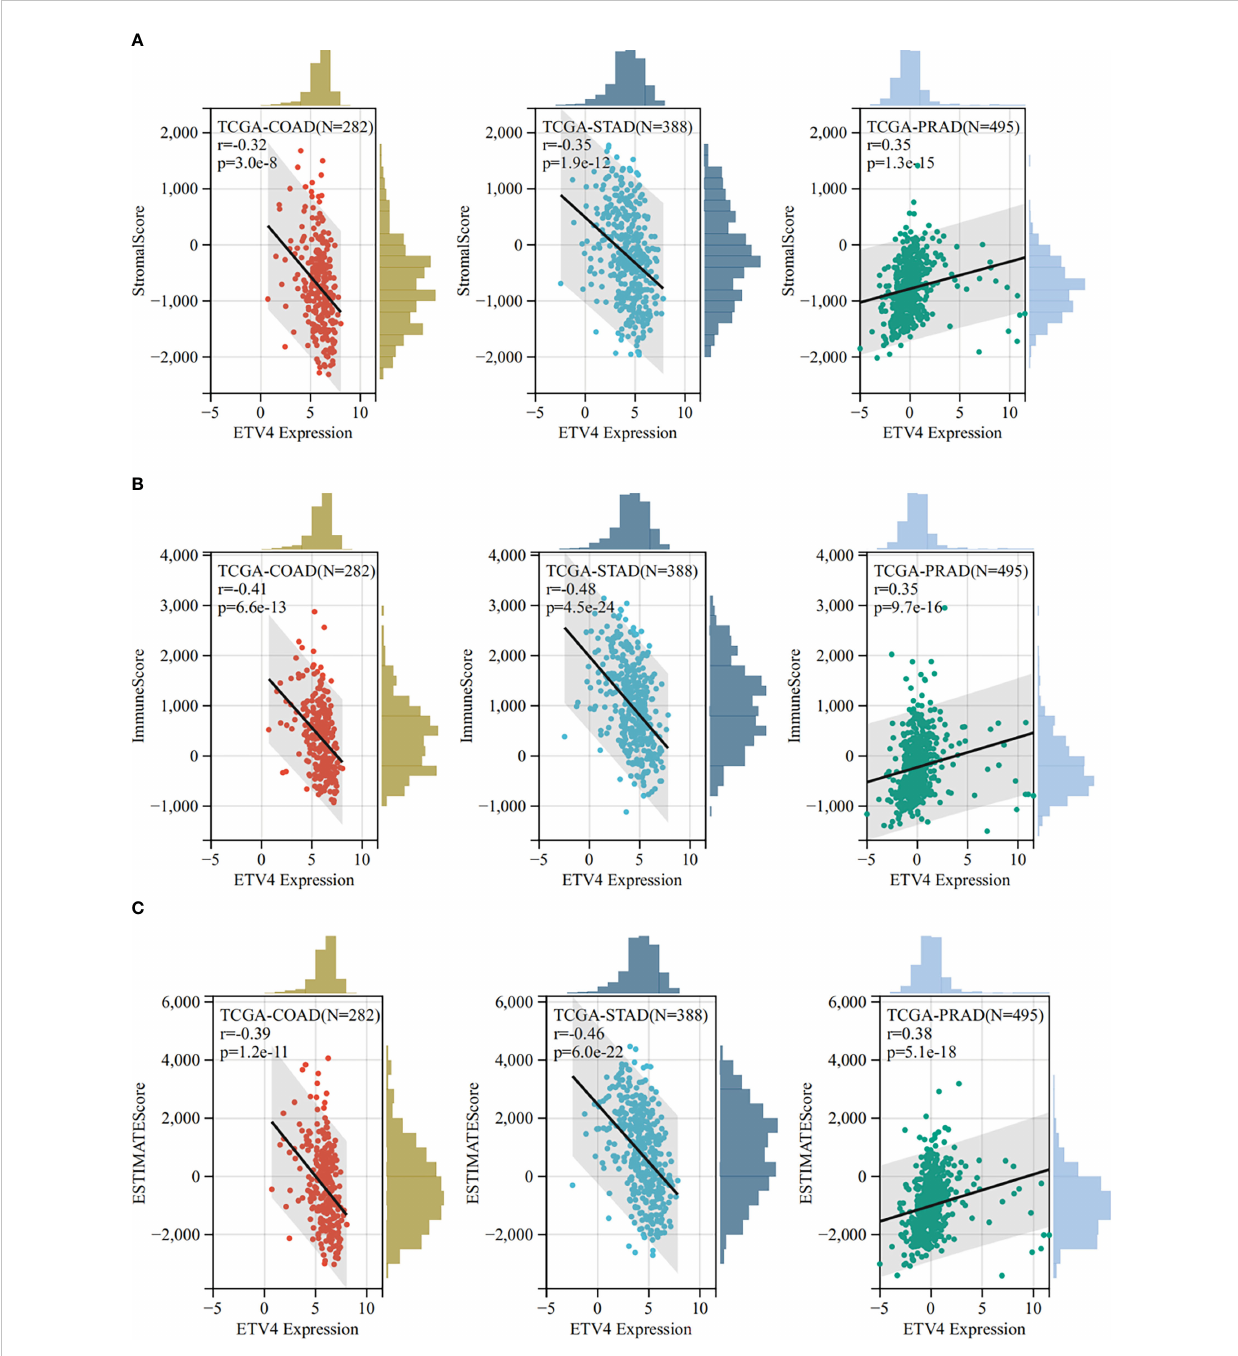
FIGURE 5 The Sangerbox online tool was used to estimate immune and stromal ratios of various cancers. (A) The relationship between ETV4 expression and StromalScore in prostate adenocarcinoma, colon adenocarcinoma, and kidney renal clear cell carcinoma. (B) The relationship between ETV4 expression and ImmuneScore in colon adenocarcinoma, prostate adenocarcinoma, and stomach adenocarcinoma. (C) The correlation between ETV4 expression and